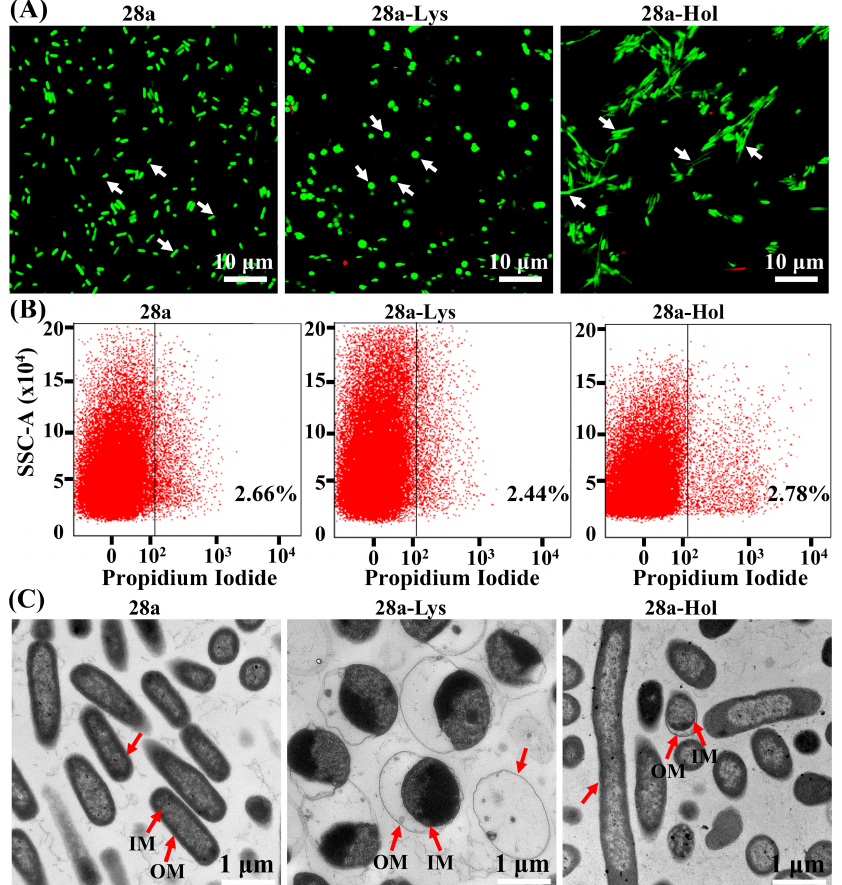
Figure 6. Effect of X2-Lys and X2-Hol on cell morphology at 12 h post-induction. ( A ) Live and dead bacterial staining experiment. ( B ) Flow cytometry scatter plots. Percentage of fluorescent events within gated region is shown in the region on the right. The x -axis shows the relative fluorescence intensity and the y -axis is the signal from the side scattered light. ( C ) Transmission electron microscopy. Scale bar (white): 1 µ m. OM: outer membrane; IM: inner membrane. 28a, empty plasmid control; 28a-Lys: Cells with pET28a-X2-Lys; 28a-Hol: Cells with